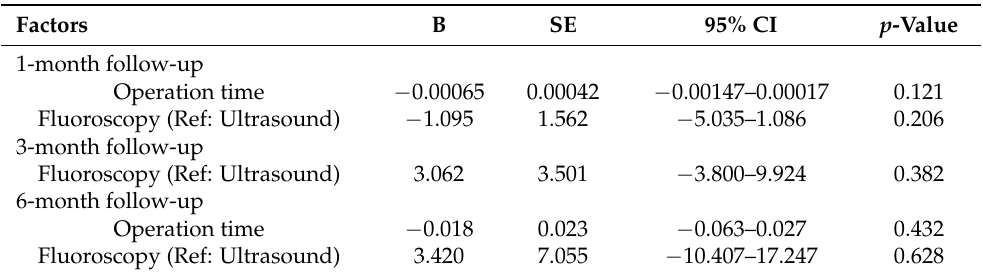
Figure 5. Meta-analysis of efficacy in pain using two radiofrequency ablation techniques to treat knee OA at the 12-month follow-up.